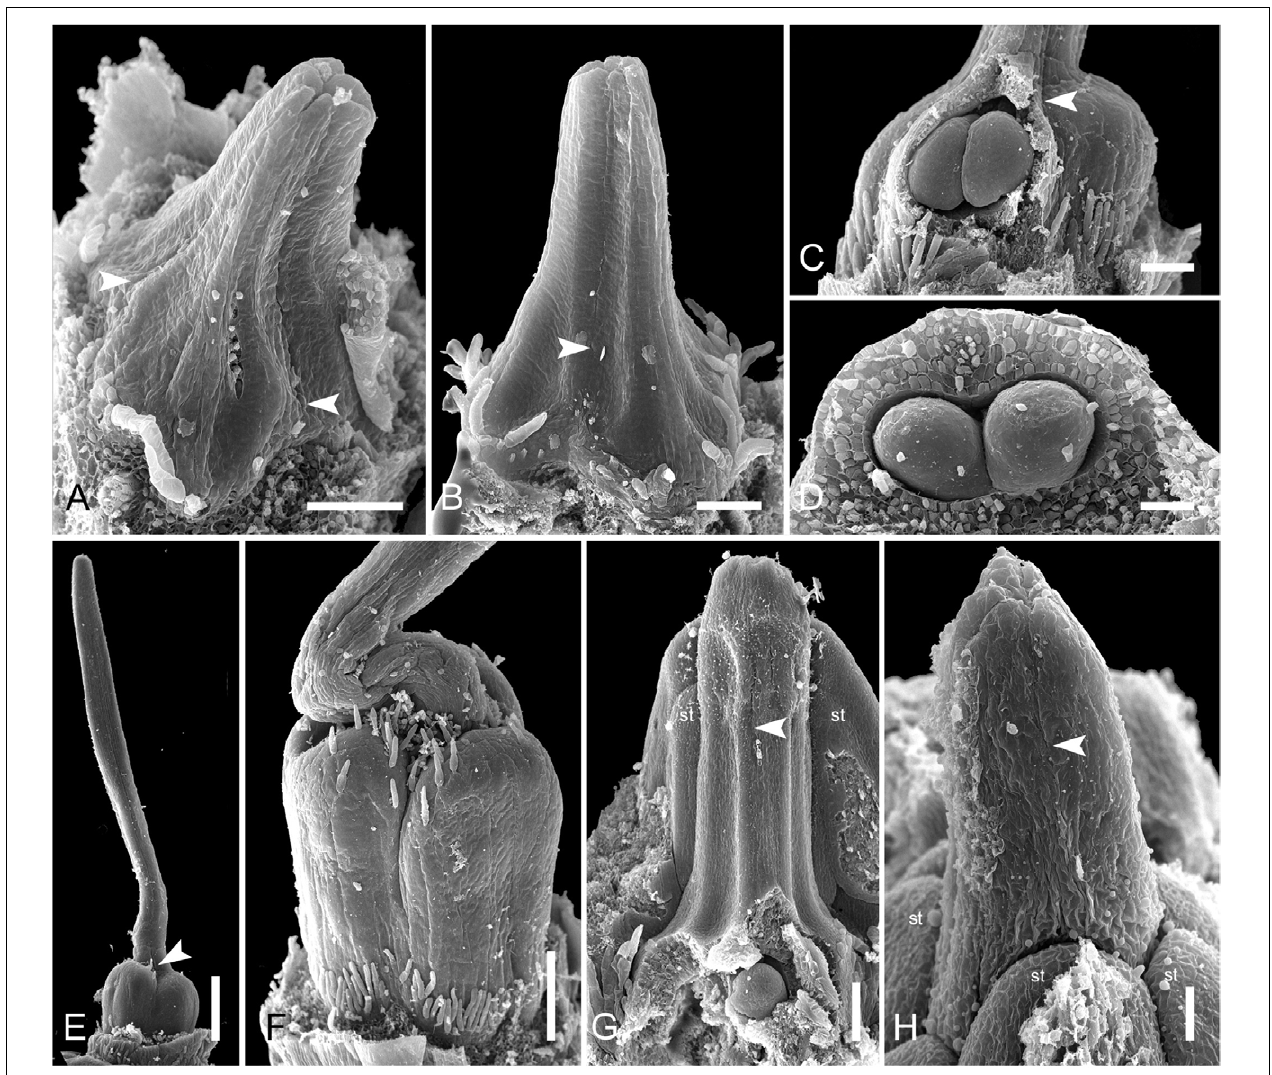
FIGURE 11 | Flower development in Rapateoideae. Spathanthus unilateralis and Rapatea paludosa , late stages of gynoecium development. (A–F) Spathanthus unilateralis . (A,B) Subsequent stages of relatively young gynoecia with well differentiated ovary. Lines of postgenital fusion are clearly visible. Note that ovary locules are not bulging at these stages and carpel tips form triradiate pattern which is needed to complete postgenital gynoecium closure. (C,D) Dissected ovaries with slightly bulging locules to show two pendent ovules per carpel. Side view (C) and view from ovary bottom (D) . Gynoecium with prominent asymplicate zone. Elongation of free plicate carpel parts (asymplicate zone), surrounding organs are removed in panel (D) to show gynoecium base. (E) Young gynoecium with postgenitally closed style. (F) Mature ovary with bulging locules. (G,H) Rapatea paludosa . (G) Gynoecium at stage of ovule initiation (H) Style tip, stage later than in panel (G) . St, stamen. Arrowheads show visible boundaries of postgenital fusion in asymplicate zone. Scale bars = 100 mkm in panels (A–C,G) , 50 mkm in panel (D) , 500 mkm in panel (E) , 300 mkm in panel (F) , and 30 mkm in panel (H)